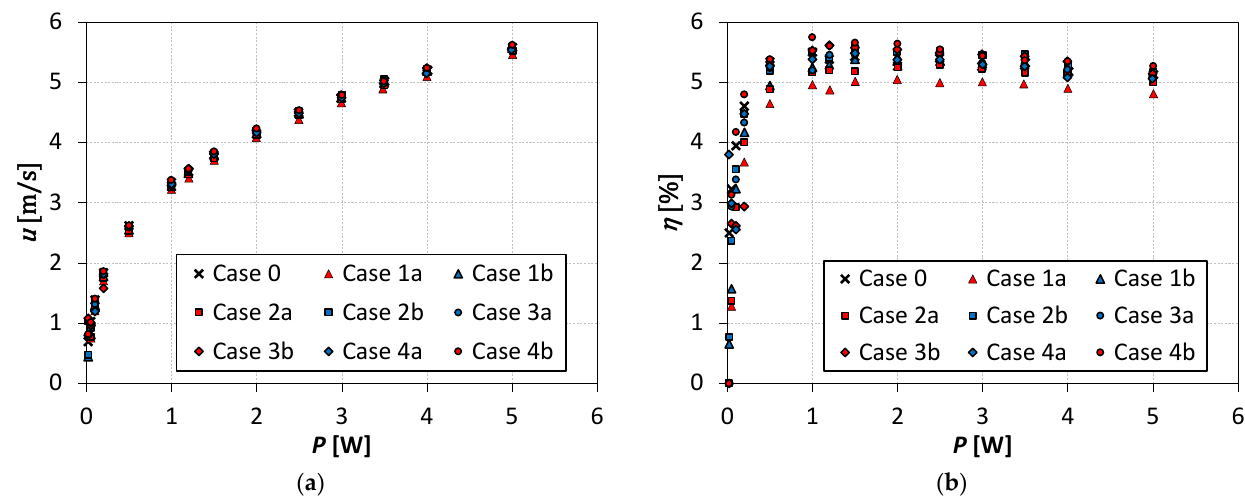
Figure 5. SJ velocity ( a ) and synthetic jet actuator (SJA) efficiency ( b ) as a function of power at resonant frequency f n .